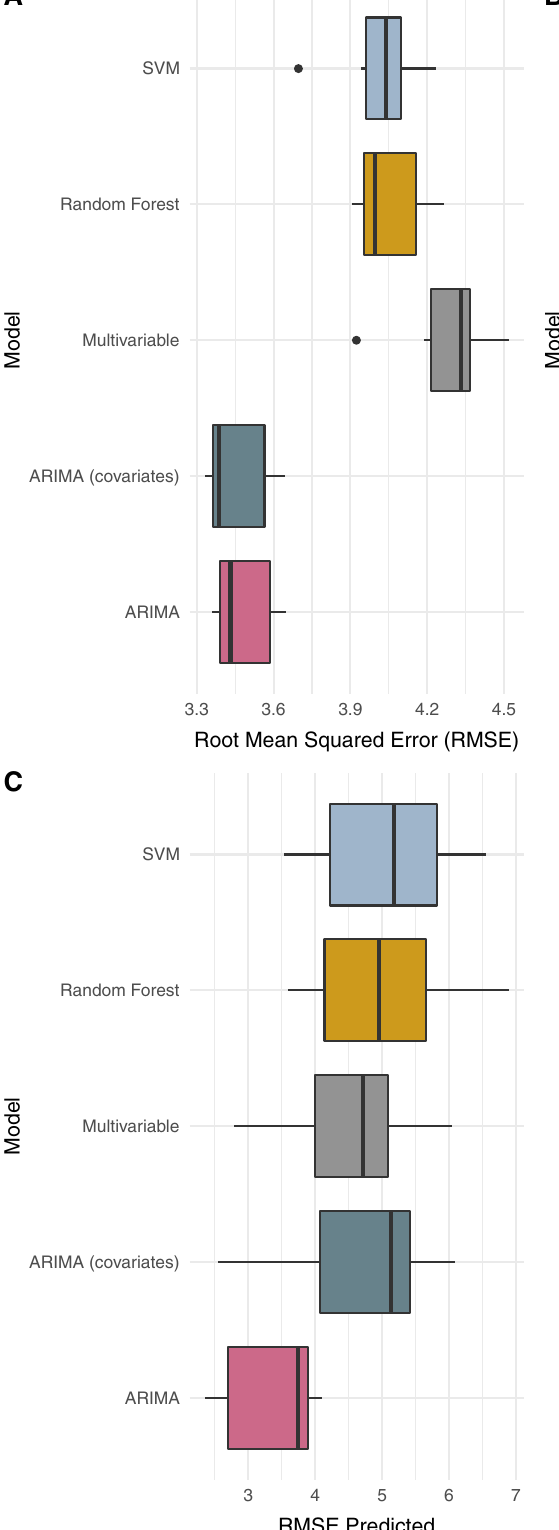
Figure 4. Comparison of models fitted to data for the Centre region. (A) Root Mean Squared Error (RMSE) of fitted values, (B) model R-squared and (C) RMSE of out-of-sample predictions. The models are Support Vector Machines Regression (SVM), Random Forest Regression, Multivariable linear regression, and ARIMA with [i.e., ARIMA (covariates)] and without (i.e., ARIMA) search data as explanatory